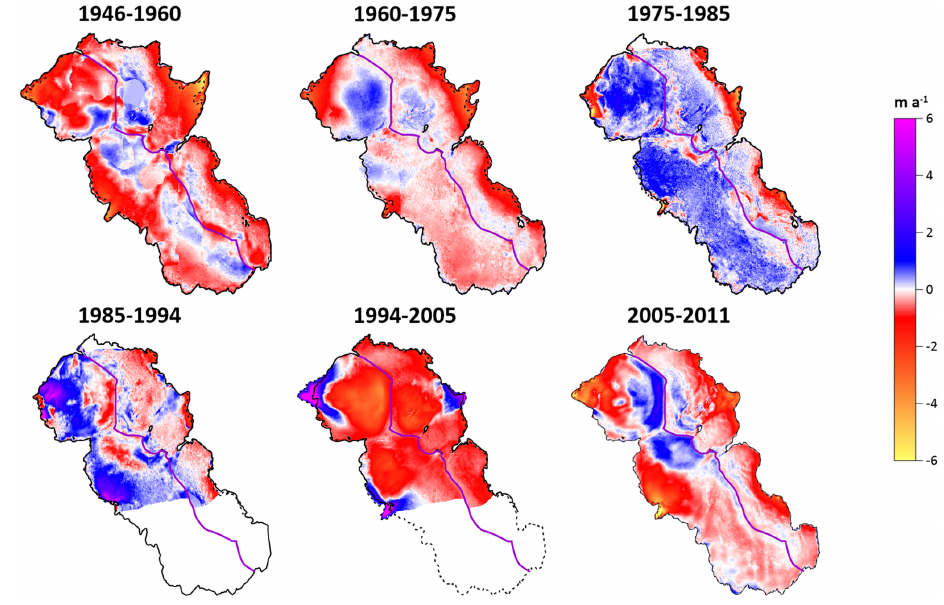
Figure 6. The average annual elevation change of Drangajökull during six intervals since 1946. Red indicates thinning and blue thickening.